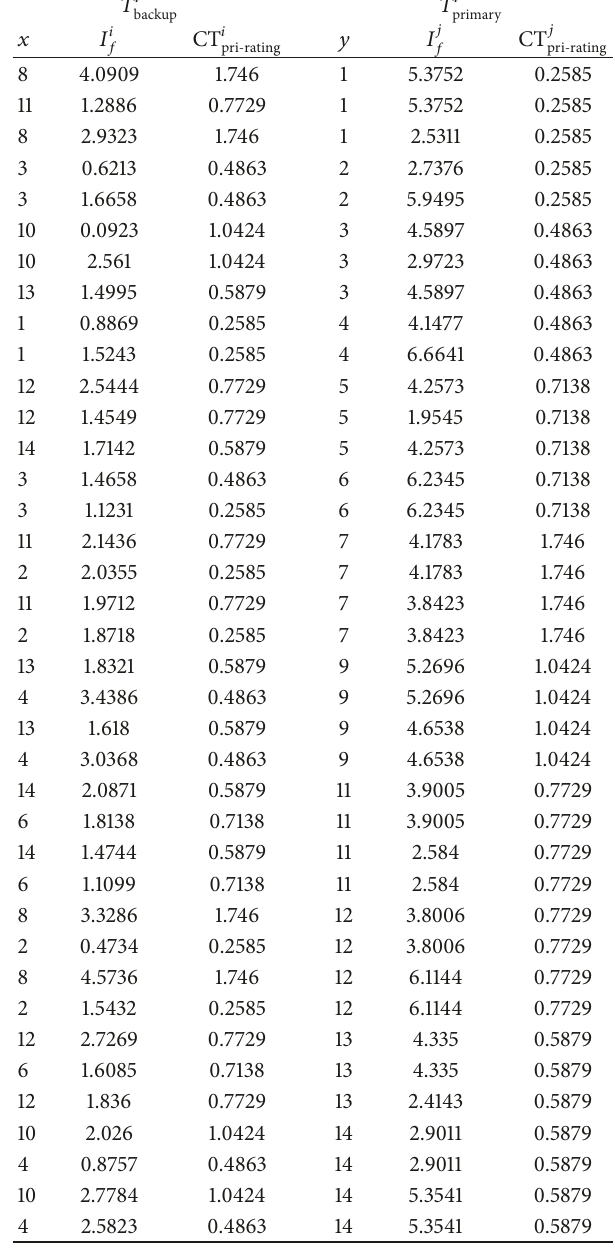
and 𝑇 of 6-bus backup primary